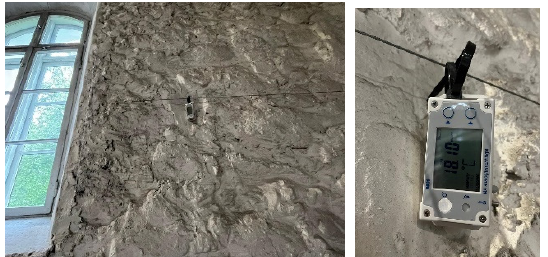
Figure 2. Example of mounting HOBO MX measuring instruments on the outer wall.